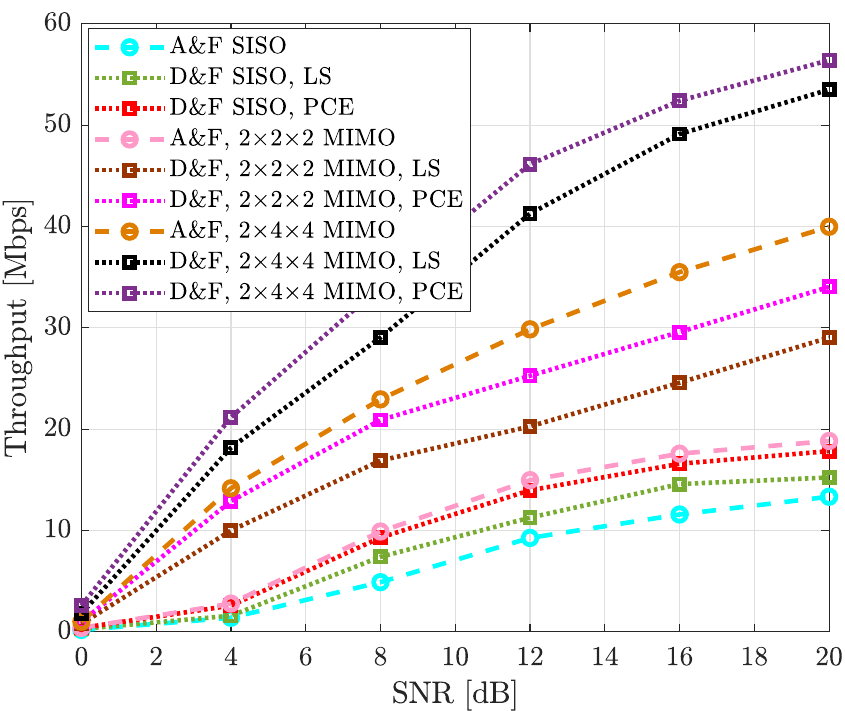
Figure 14. Throughput comparison for different uplink mmWave NR-RN co-operative schemes implemented with the 256-QAM